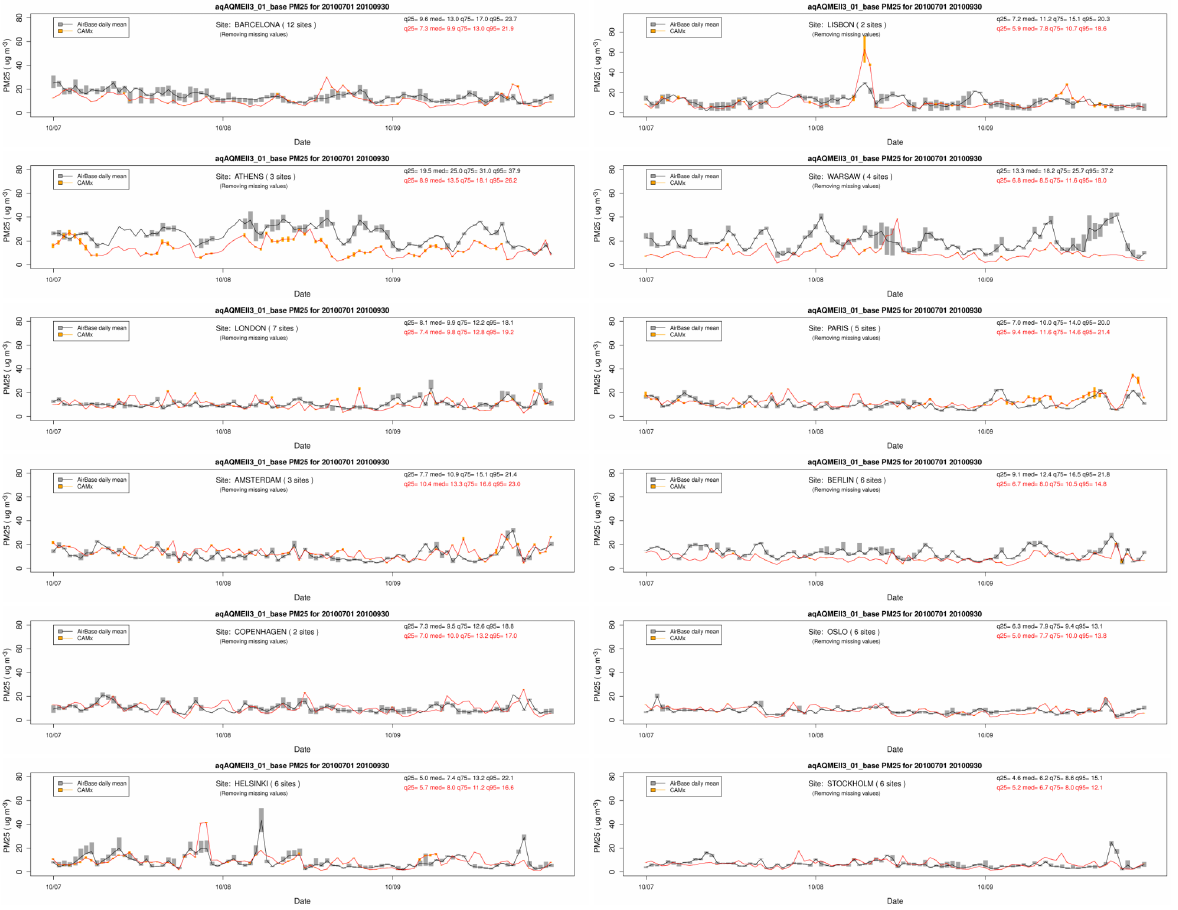
Figure 5. Time series of the box and whisker plots for the distribution of the observed (black and grey) and computed (red and orange) daily concentrations of PM 2 . 5 at background AirBase sites in the selected cities for 1 July–30 September 2010. Bars show the interquartile range and lines show the median values. Values for the 25th, 50th, 75th, and 95th quantiles are also reported for each city.